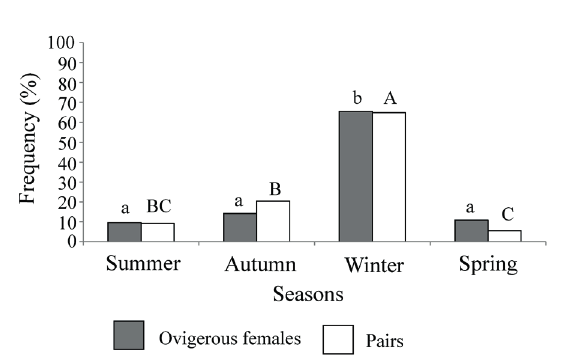
Figure 3. Relative frequency (%) of ovigerous females and couples in pre-copula of Hyalella bonariensis from Silveira Martins, state of Rio Grande do Sul, Brazil. Lower case letters indicate the comparison of ovigerous females frequency between seasons and capital letters compare the frequency of the couples. Columns with at least one letter in common are not significantly different (p>0.05).